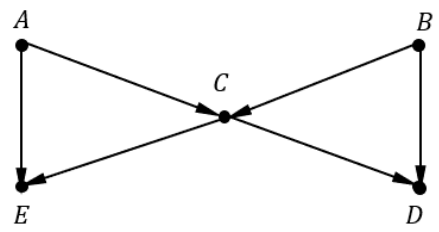
Figure 1. An example of